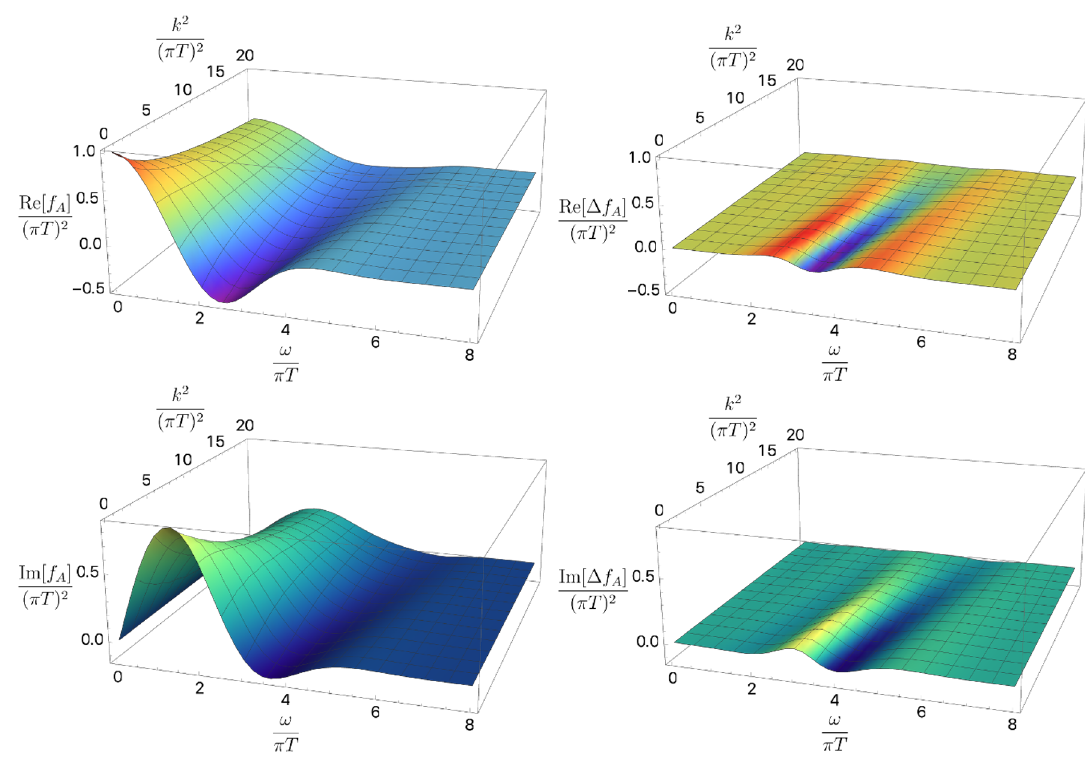
Figure 3 . Left column: real and imaginary parts for the A component of the all order drag force as functions of ! and k 2 , evaluated with the spectral method. Right column: the resulting di(cid:11)erences between the A components as evaluated through the spectral and matching